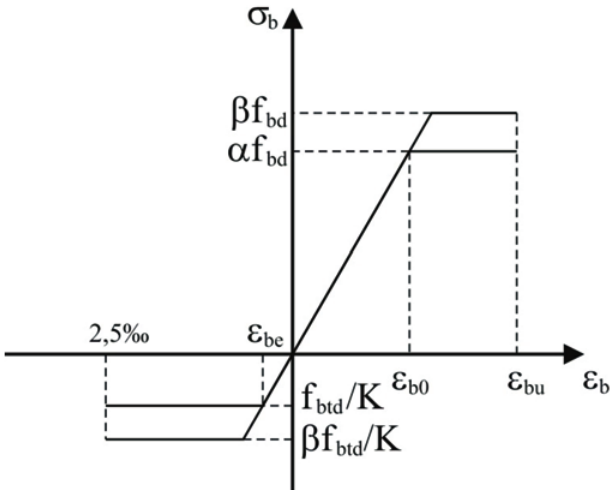
Stress-strain diagrams adopted for the proposed